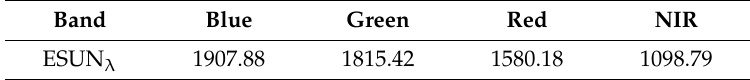
Table 4. Solar irradiance at the top of atmosphere of the GF-4/PMS in multispectral bands. Band Blue Green Red NIR ESUN (cid:2971)